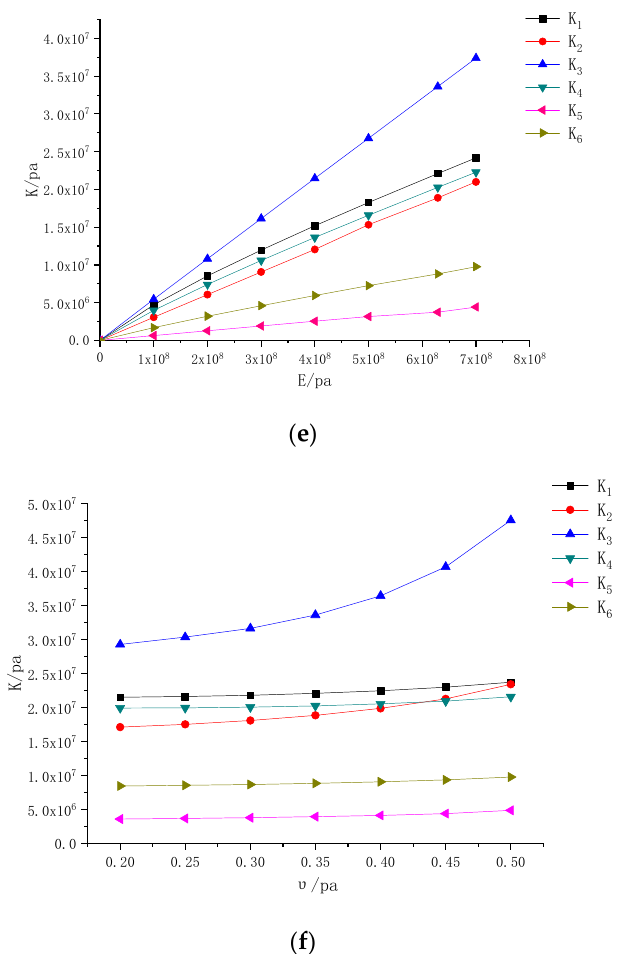
Figure 5. Influences of various factors on foundation spring stiffness: ( a ) K versus 1/ h , ( b ) K versus 1/ H , ( c ) K versus d , ( d ) K versus 1/ b , ( e ) K versus E , ( f ) K versus υ . (2) Horizontal Relative Displacement of Strata in a Loess Area A numerical model of free field dynamic response considering seismic intensity, ground motion characteristics and loess soil characteristics was established, as shown in Figure 6. Where 1 is an infinite element boundary, 2 denotes a fixed boundary, and 3 is bedrock. The maximum response horizontal displacement of free field was obtained by inputting the Xi’an artificial wave, Taft wave, and Songpan wave in turn (Table 1 and Figure 7).